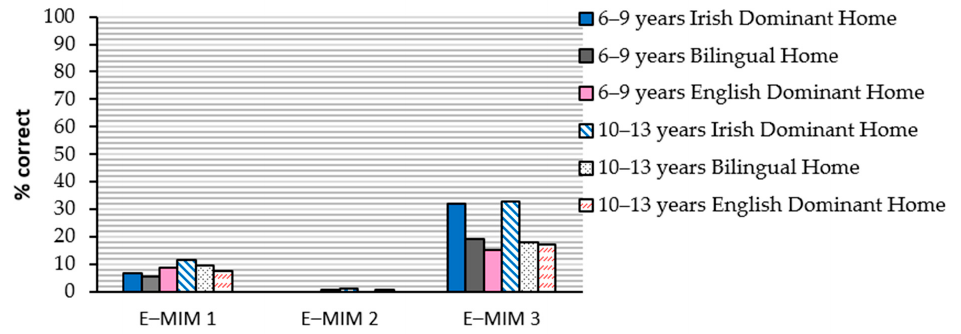
Figure 1. Percent correct scores for child participants by language background and age on the Expressive Measure of Irish Morphosyntax